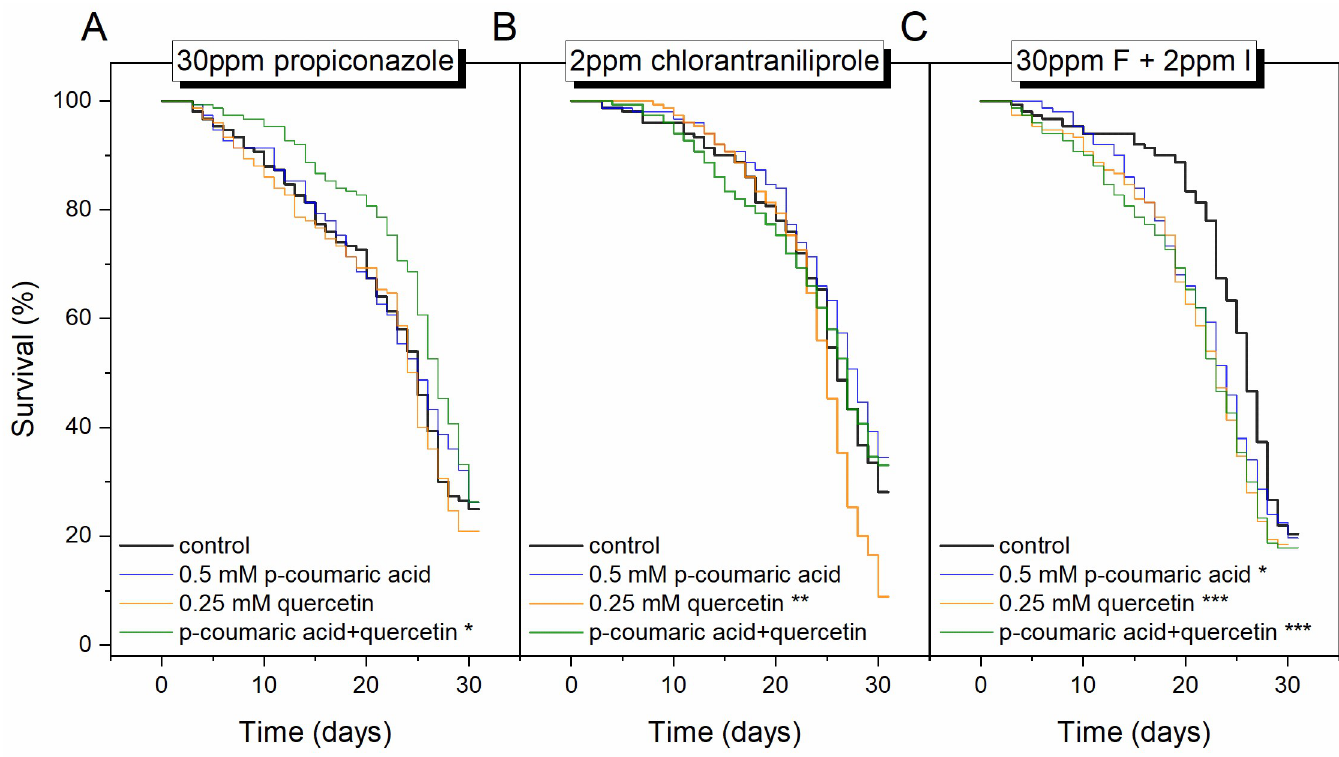
Fig 2. Kaplan–Meier plots of honey bee longevity on diets varying in phytochemical and pesticide content. (A) 30 ppm fungicide propiconazole (B) 2 ppm insecticide chlorantraniliprole, (C) 30 ppm propiconazole + 2 ppm chlorantraniliprole (F: fungicide propiconazole, I: insecticide chlorantraniliprole; n = 600 for each pesticide group and n = 150 for each phytochemical subgroup; ��� = p < 0.001, �� = p < 0.01, � = p < 0.05, Tarone-Ware test between the treatment and control).